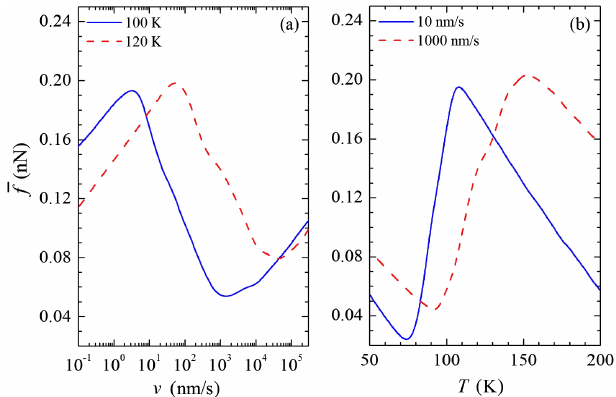
(cid:4) f FIG. 2. (a) Mean friction force versus pulling velocity v by numerically solving (1)–(5), as detailed in the main text. Solid blue line: T ¼ 100 K . Dashed red line: T ¼ 120 K . (b) Mean (cid:4) f friction force versus temperature T for v ¼ 10 nm = s (solid blue line) and v ¼ 1000 nm = s (dashed red line). All model parameters are adopted from our fitting to the experimental data from Ref. [6] and are listed in the caption of Fig.